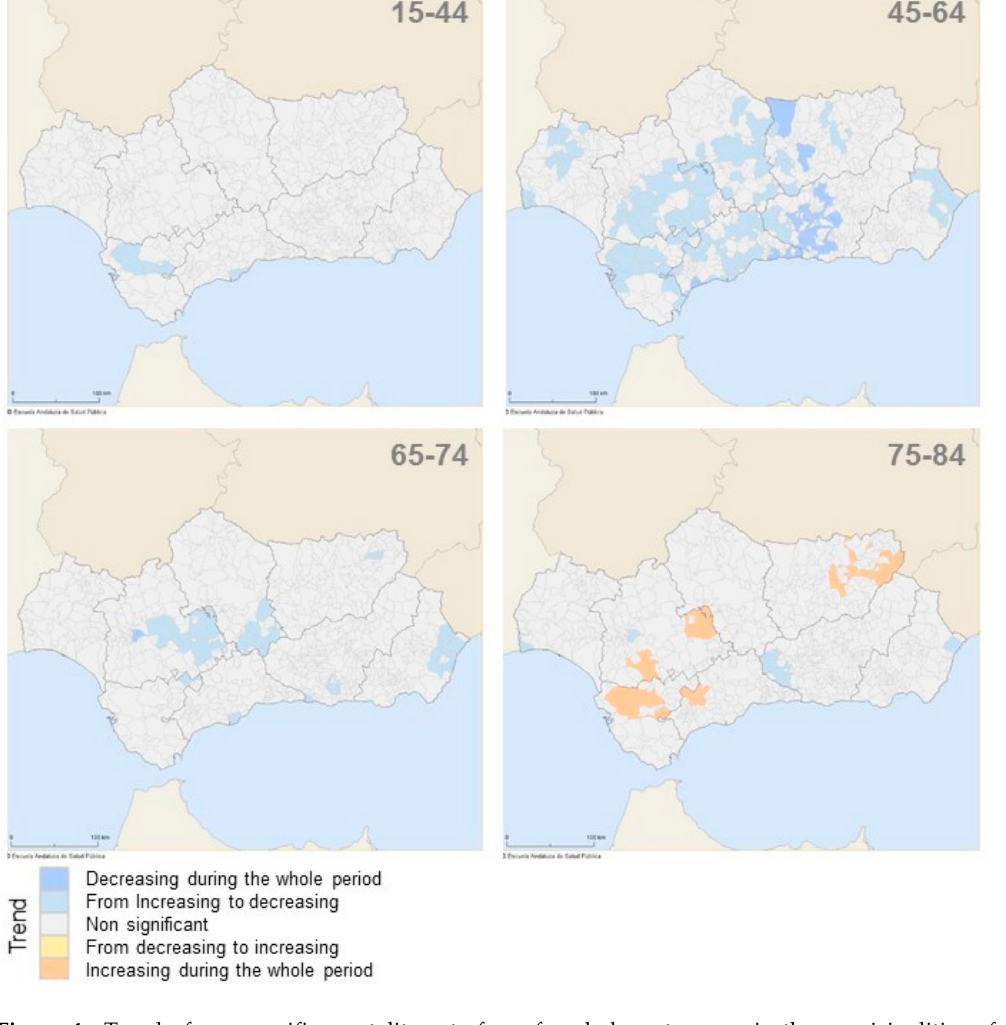
Figure 4. Trend of age-specific mortality rate from female breast cancer in the municipalities of Andalusia (southern Spain), 1981–2012.